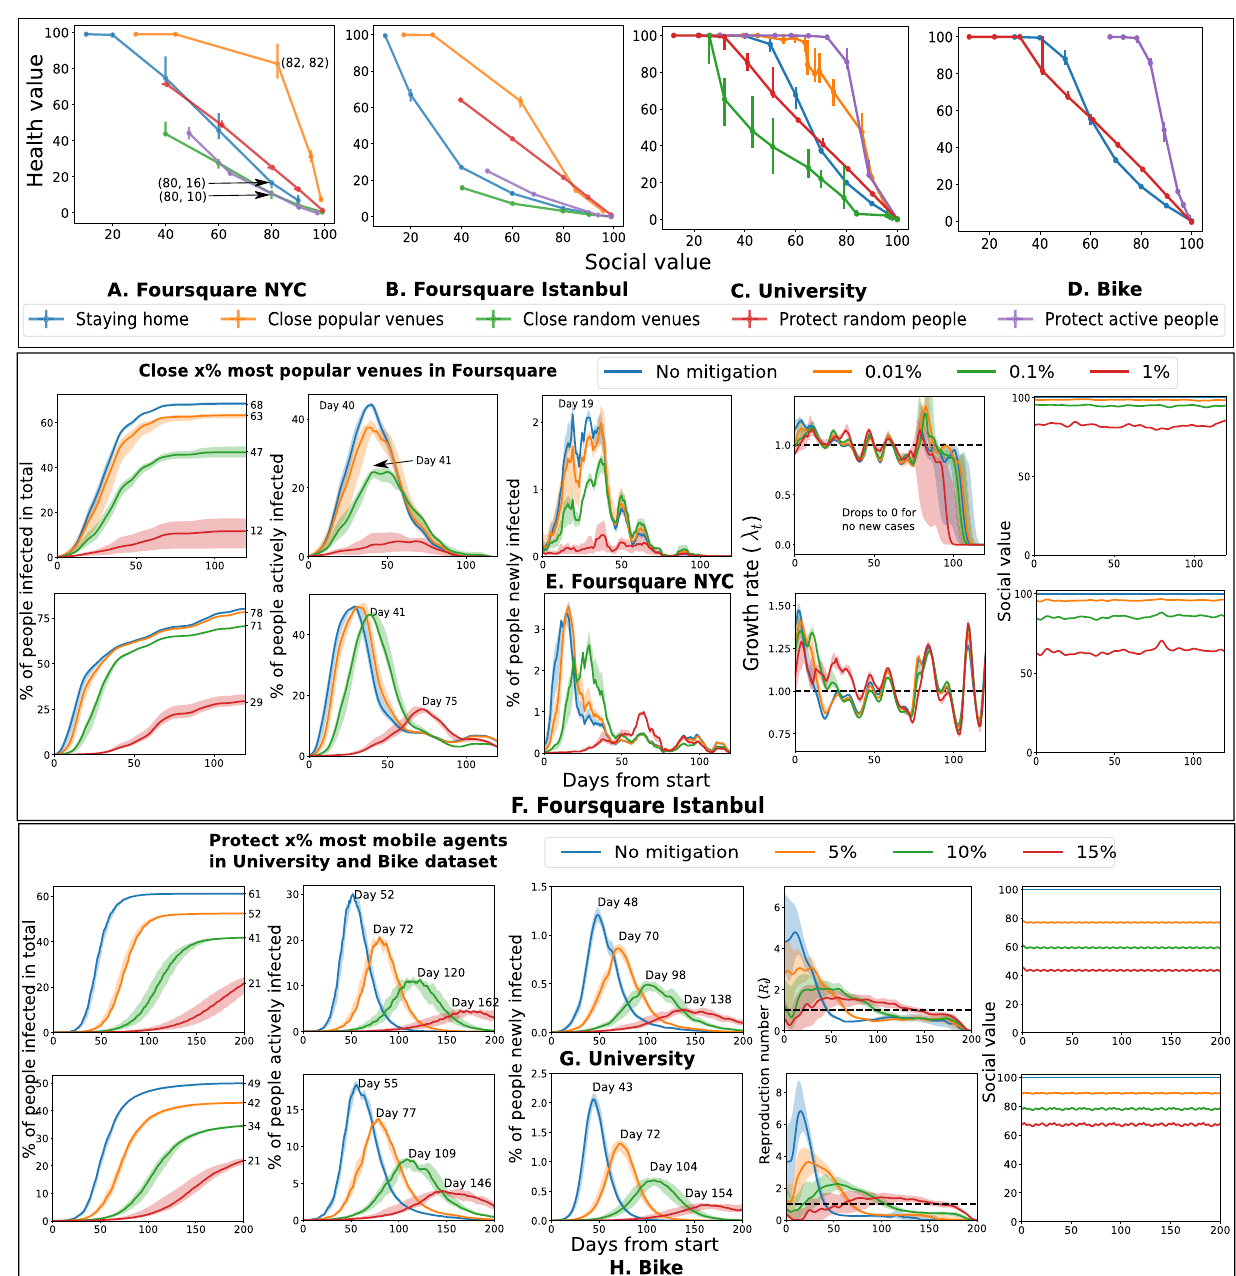
Figure 4. Across all datasets, the most effective strategies in terms of their health and social values consider the heterogeneity of mobility ( A – D ) and ( E – H ) present the details of the best strategies. The health value quantifies the percentage of people not infected compared to without intervention scenario, and the social value is the percent of check-ins or meetings that remain under intervention. An ideal strategy would have both high health, and social values. Across Foursquare datasets, closing the most popular venues is the most effective strategy ( A , B ); isolating or protecting the most active agents is the best strategy in University ( C ) and the Bike ( D ) datasets. The Bike dataset does not have venues and therefore it omits corresponding strategies. ( E )–( H ) show details of the best strategies. They reduce infections to a large extent (closing the most popular 1% venues results in 57% reduction in infection in the NYC dataset), delays and lowers the peak of active infections (protecting the most active 5% agents in the University dataset delays the peak by 20 days) and maintain high social values ( 1% most popular venues contribute to 20% check-ins in the NYC